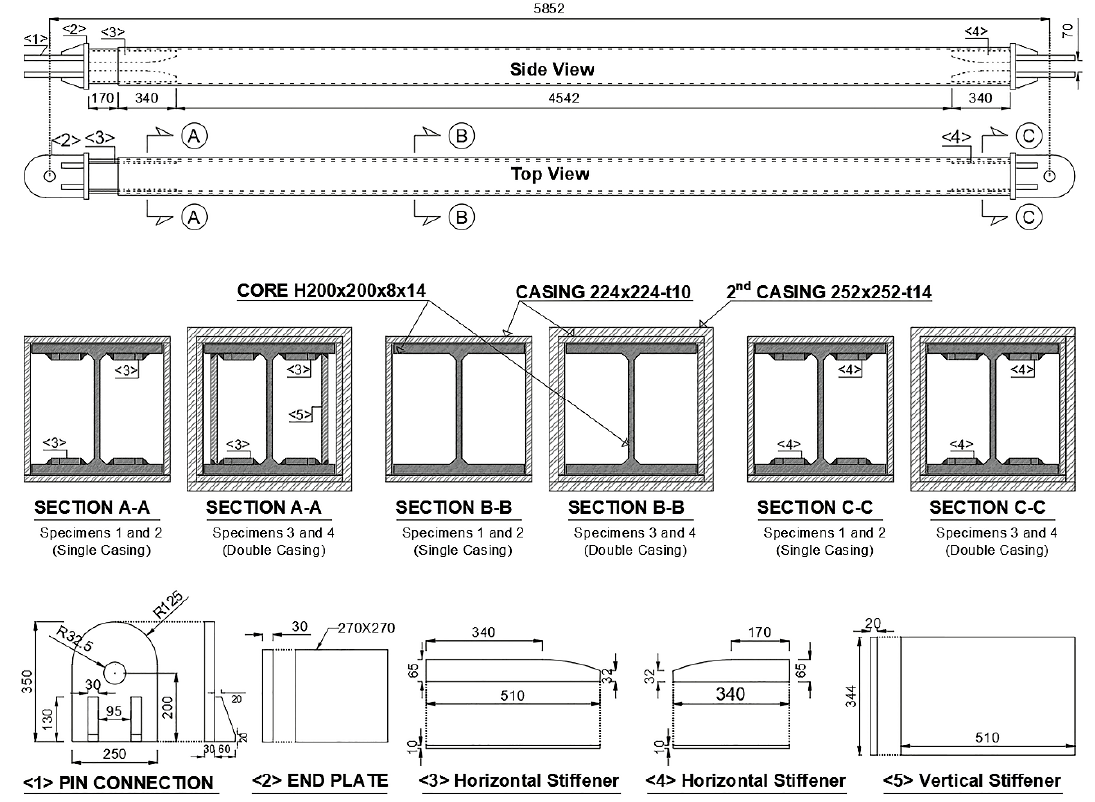
Figure 2. Details of test specimens.